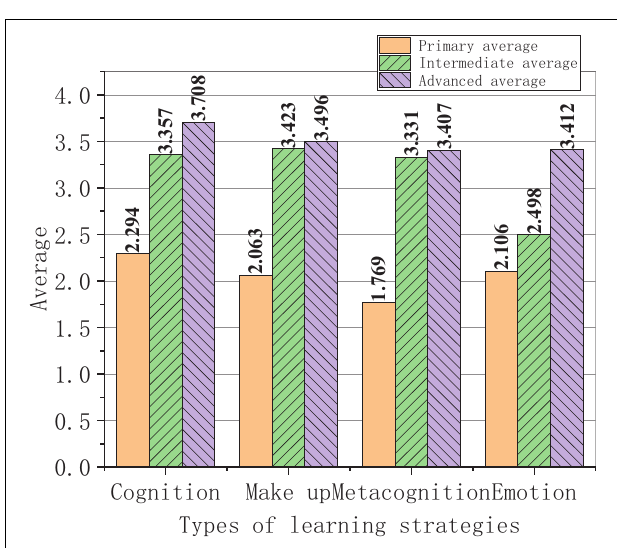
FIGURE 10 | Relation between the use of learning strategies of foreign students and their different levels of Chinese proficiency.